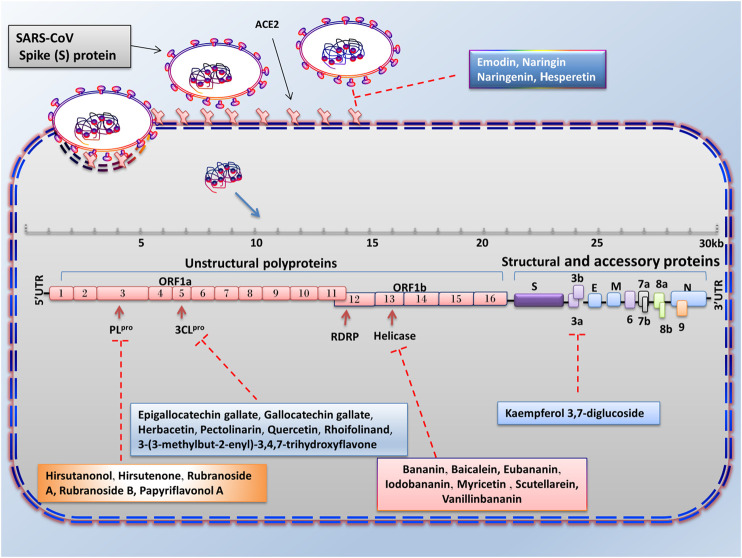
Advantages of employing natural compounds against infection and replication of SARS-CoV. Some of the natural compounds by reducing the expression of 3CLpro, PLpro, helicase, and 3a genes can play a therapeutic role in inhibiting the SARS-CoV infection.